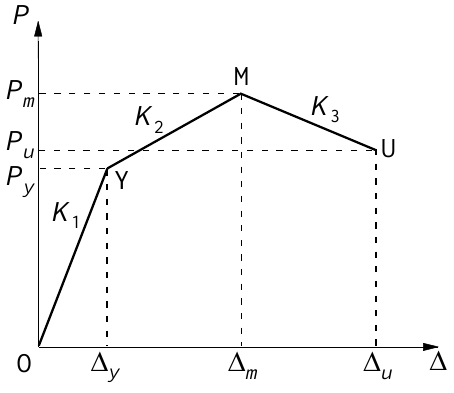
Figure 22. The triple-fold linear restoring force model.